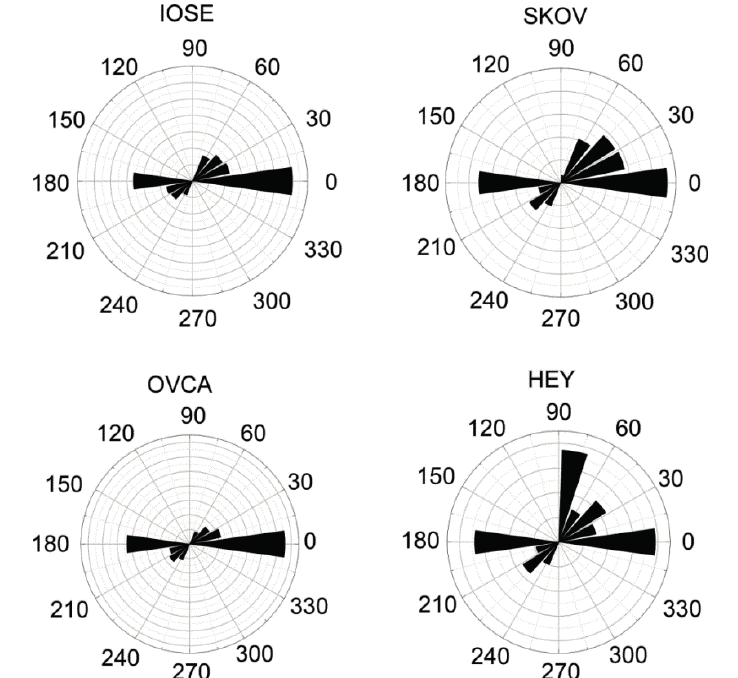
Figure 5. Directed migration of the four cells lines along the fiber axis of the high slope gradient shown as polar plots. The IOSE, OVCA433, and SKOV-3.ip1 cells had similar responses of directed migration based on the Rayleigh test and the pairwise U 2 Watson